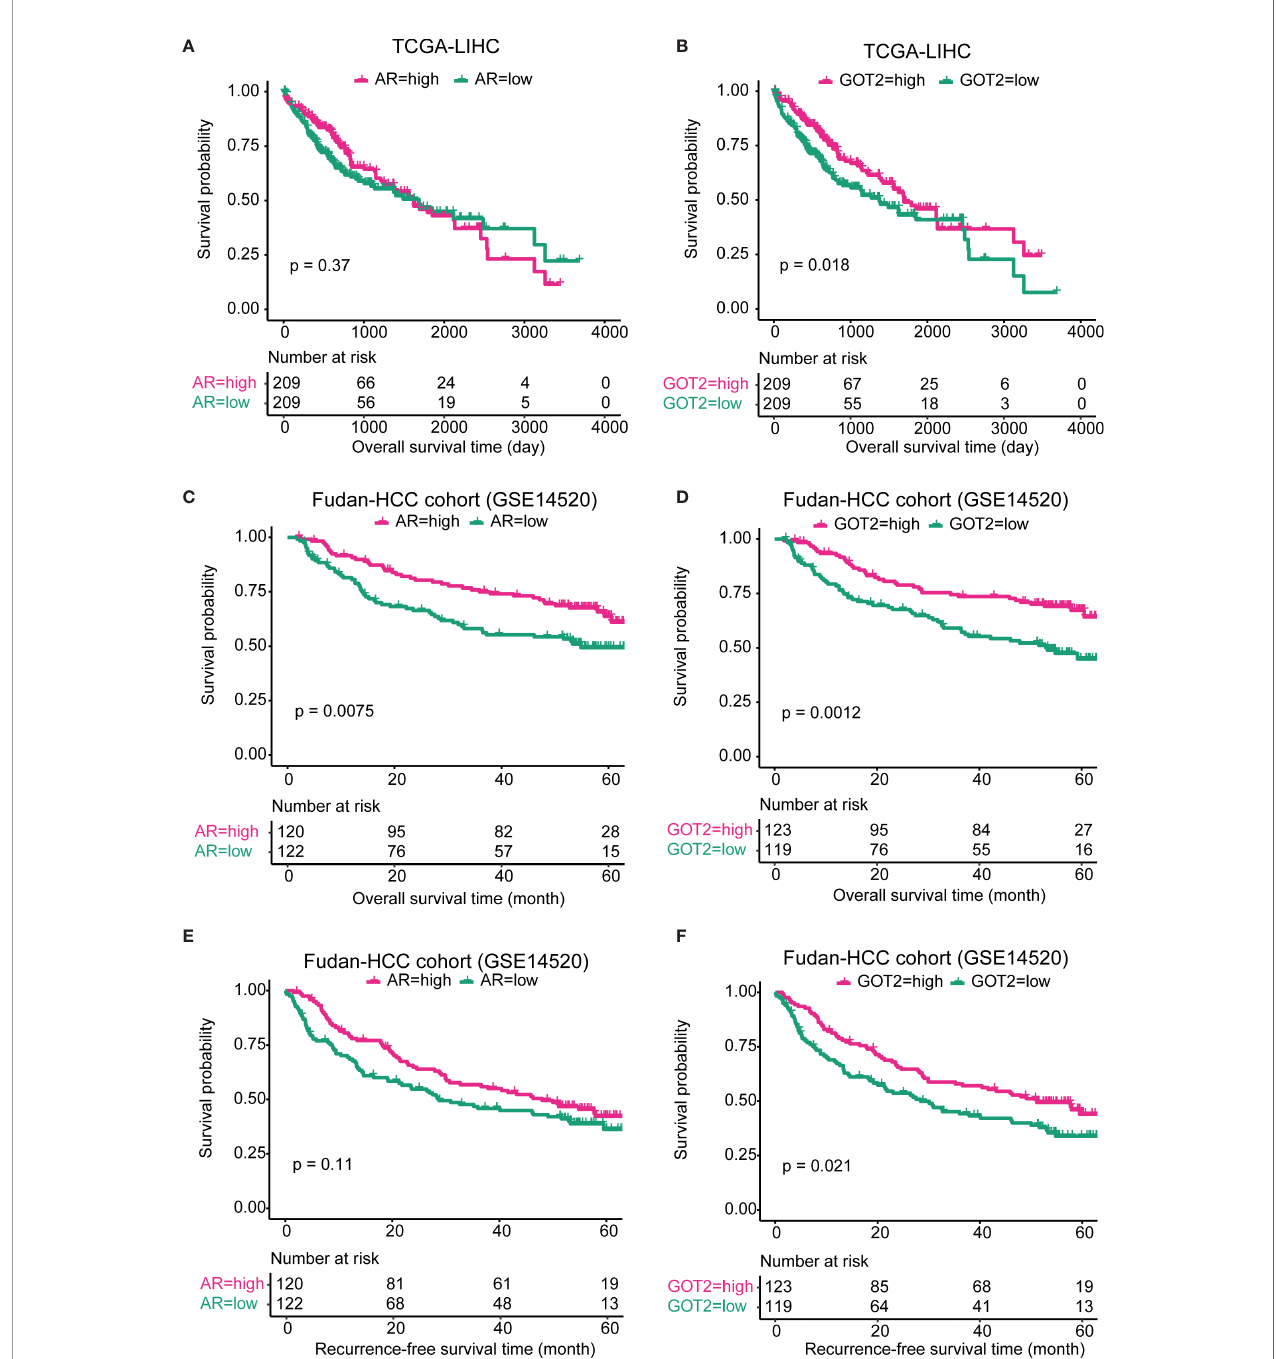
FIGURE 5 | Kaplan – Meier curves for AR and GOT2 in TCGA-LIHC and Fudan-HCC cohorts. The overall survival analyses of AR and GOT2 in TCGA-LIHC cohort were displayed in (A, B) . The overall and progression-free survival analyses of the two genes in Fudan-HCC cohort were displayed in (C, D) and (E, F) ,